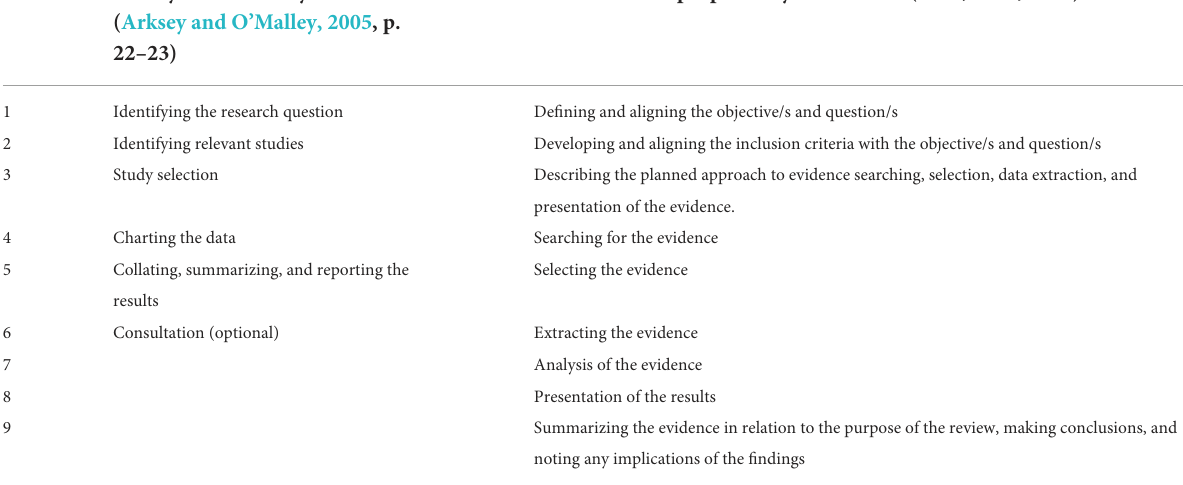
TABLE 1 Scoping review frameworks (Peters et al., 2020b, p.